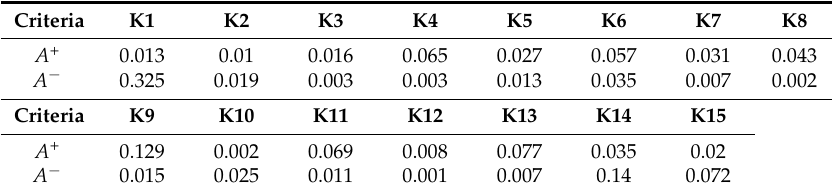
Table 8. The ideal solution and negative